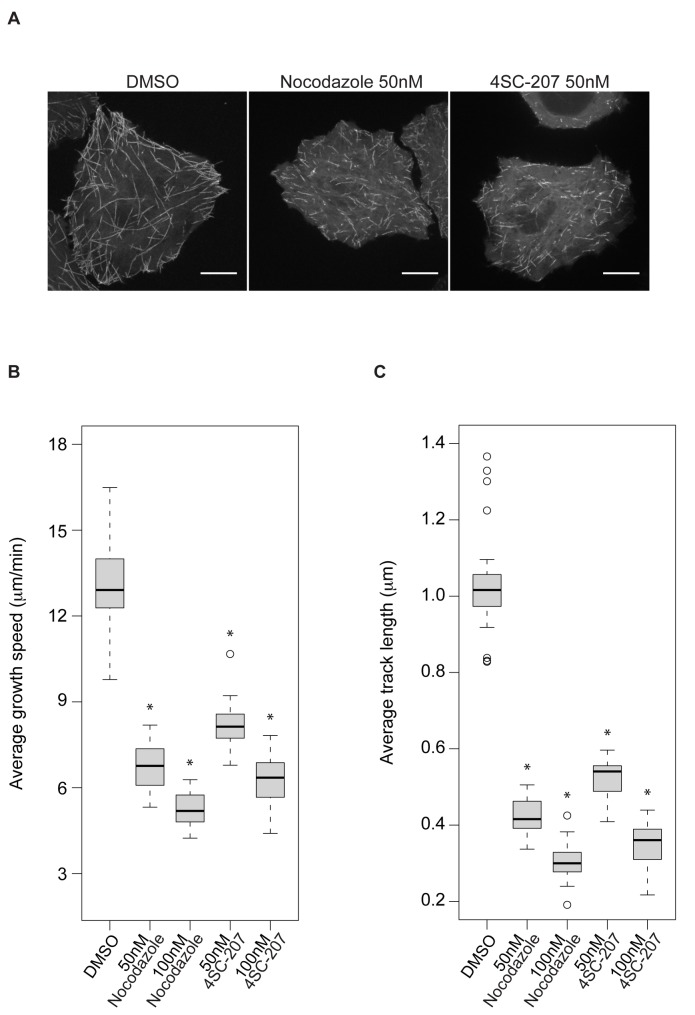
4SC-207 reduces microtubule growth rates and track lengths.(A) Time projections (the maximum intensity projections of all time points) of time-lapse sequences of interphase HeLa cells stably expressing EB3-EGFP (see Videos S5, S6 and S7) treated with 0.1% DMSO, 50nM nocodazole or 50nM 4SC-207 (scale bar 5μm). (B) Box plot representing the distributions of average growth speeds of microtubules in interphase HeLa cells stably expressing EB3-EGFP treated with 0.1% DMSO, nocodazole (50 and 100nM) or 4SC-207 (50 and 100nM). For each condition 20 cells were analyzed. (C) Box plot representing the distributions of average microtubule track lengths following the different treatments. For each condition 20 cells were analyzed. Statistical significance between compound treated and DMSO treated cells in panels (B) and (C) was evaluated using the Student’s t-test and indicated with * (p<0.001). In the boxes the median of the distributions is displayed as a thick line and the whiskers extend to Q3+1.5*IQR and Q1-1.5*IQR, were Q1=quartile1, Q3=quartile3, IQR=interquartile range (Q3-Q1). Samples that fall outside the boundaries are considered outliers (open circles).